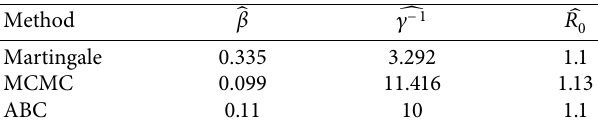
Table 3: Estimates of 􏽢 β , 􏽣 c − 1 and 􏽢 R using different